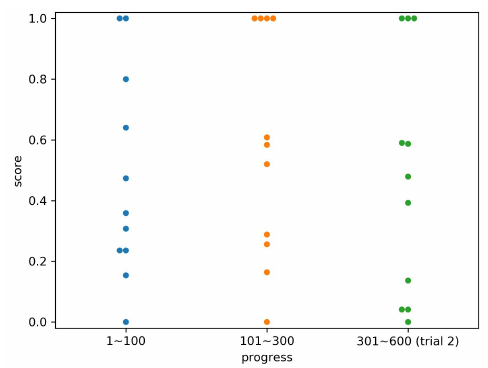
Figure 14. Scores of Subject 4 by time